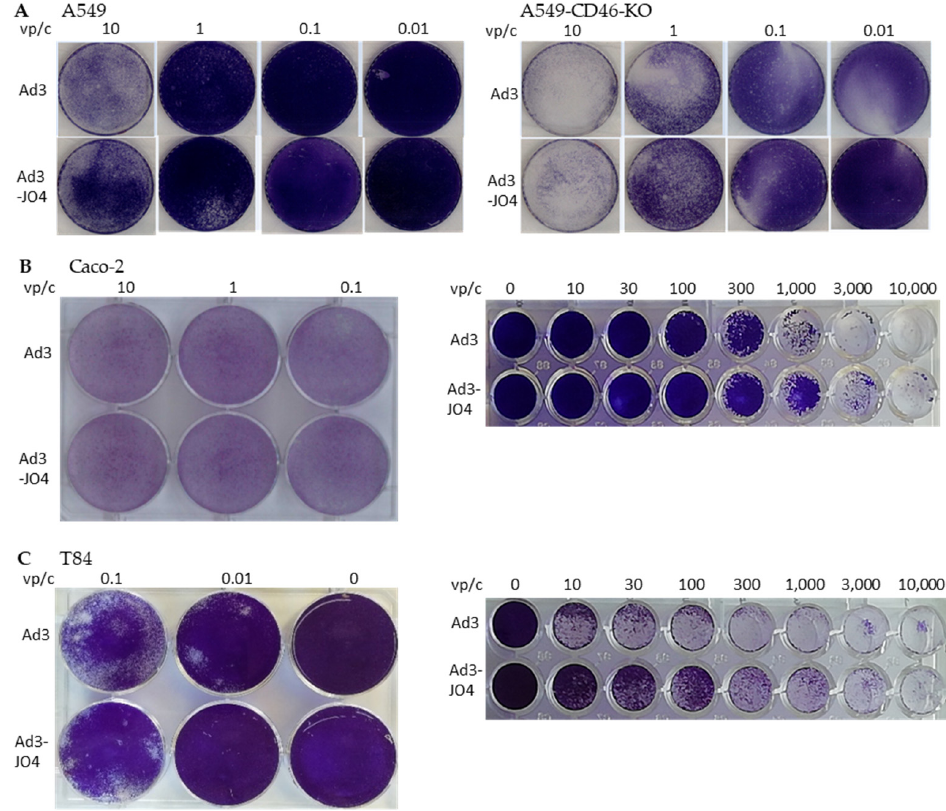
Figure 3 . Virus spreading in plaque assay and oncolytic assay. For plaque assays, cells were infected with low doses of Ad3 and Ad3-JO4, and plaques were developed under agarose overlay and stained with crystal violet. ( A ) Plaque assays in A549 and CD46 knockout A549 cell lines. ( B , C ) Plaque assays in Caco-2 and T84 cell lines (left panel). For oncolytic assays, cells were infected with Ad3 and Ad3-JO4 at ratios shown. Crystal violet staining of viable cells was used to evaluate oncolytic activity two weeks postinfection (( B , C ) right panel).